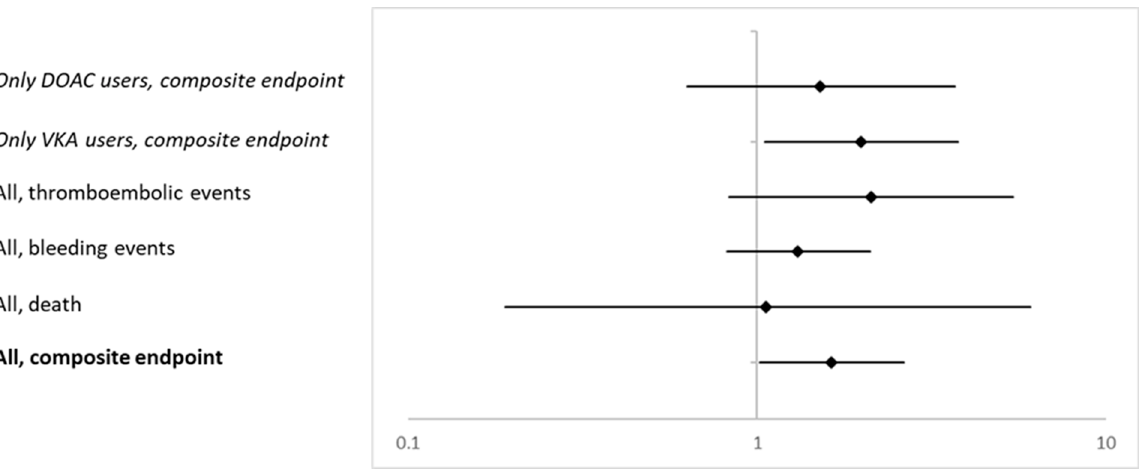
Figure 1. Adjusted ORs and corresponding 95% CI for the composite endpoint and the single items death, bleeding and thromboembolic events in the ITT cohort and for the composite endpoint including only VKA and DOAC users (all Model 3).